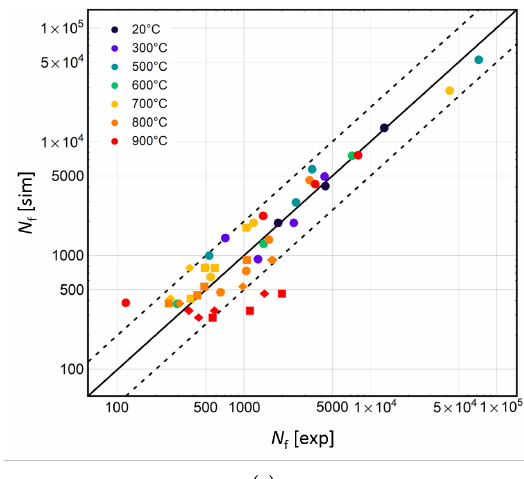
Figure 1. Calibration of the lifetime model for the Ni-Resist D-5S alloy. The deformation response of TMF tests in the temperature range 400 ◦ C to 900 ◦ C is depicted under ( a ) IP and ( b ) OP conditions. ( c ) Calculated versus experimentally determined number of cycles to failure for LCF and TMF tests at various conditions. The life assessment plot uses the incremental lifetime rule (19). The filled circles ( u ) represent LCF tests, the squares ( p ) represent non-isothermal IP tests and the diamonds ( f ) show non-isothermal OP tests. The highest temperature of the TMF tests is indicated by the